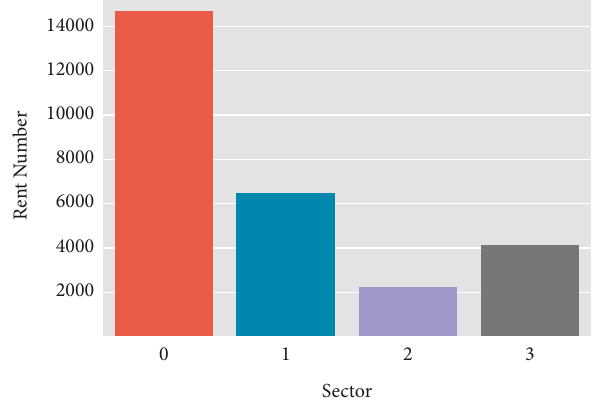
Figure 13: Sector-wise